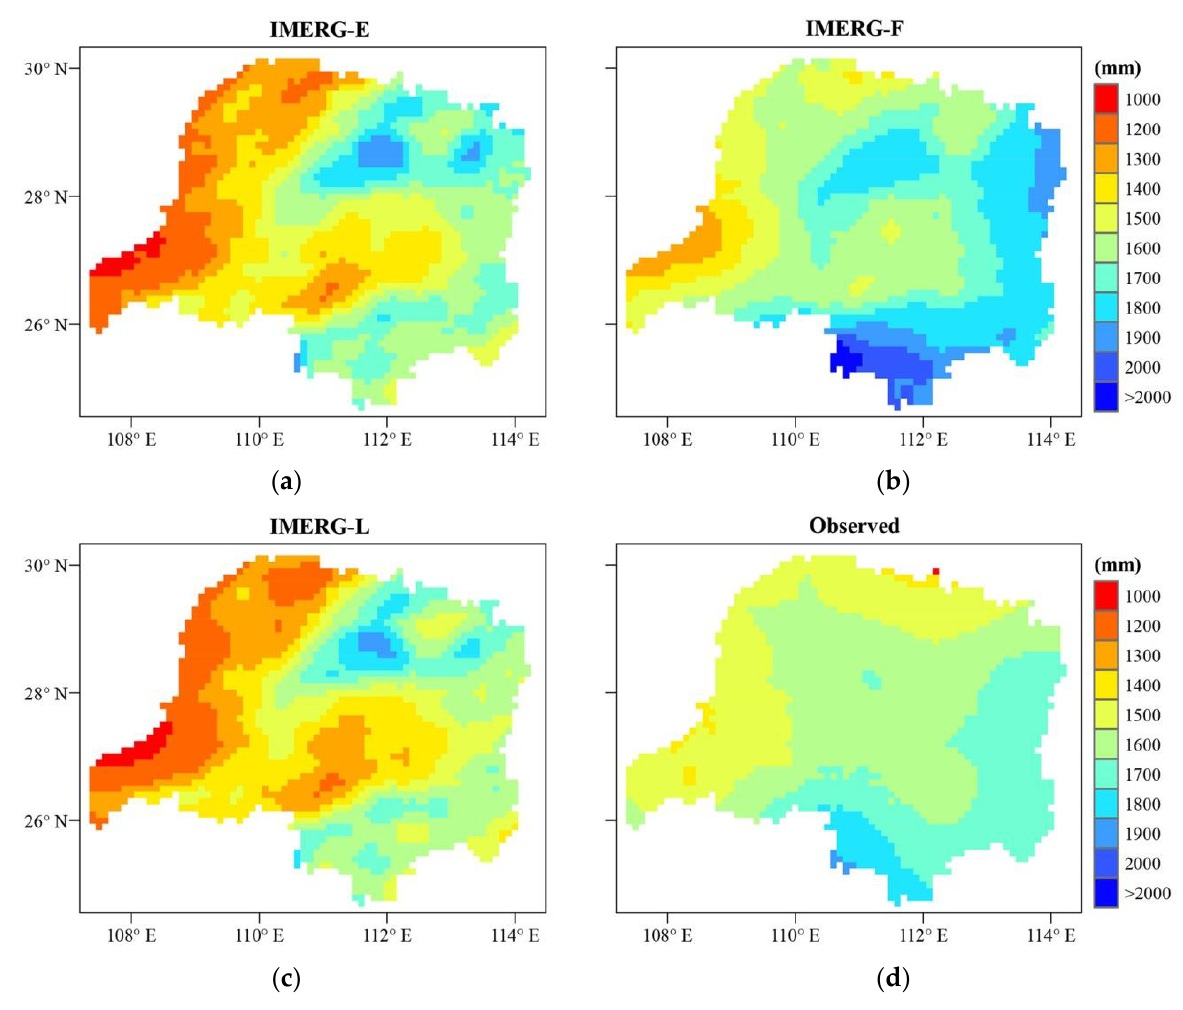
Figure 9. Spatial distribution of mean annual rainfall of IMERG-E ( a ), IMERG-F ( b ), IMERG-L ( c ), and gauged observation ( d ) over the Dongting Lake basin for the period from 2015 to 2020.